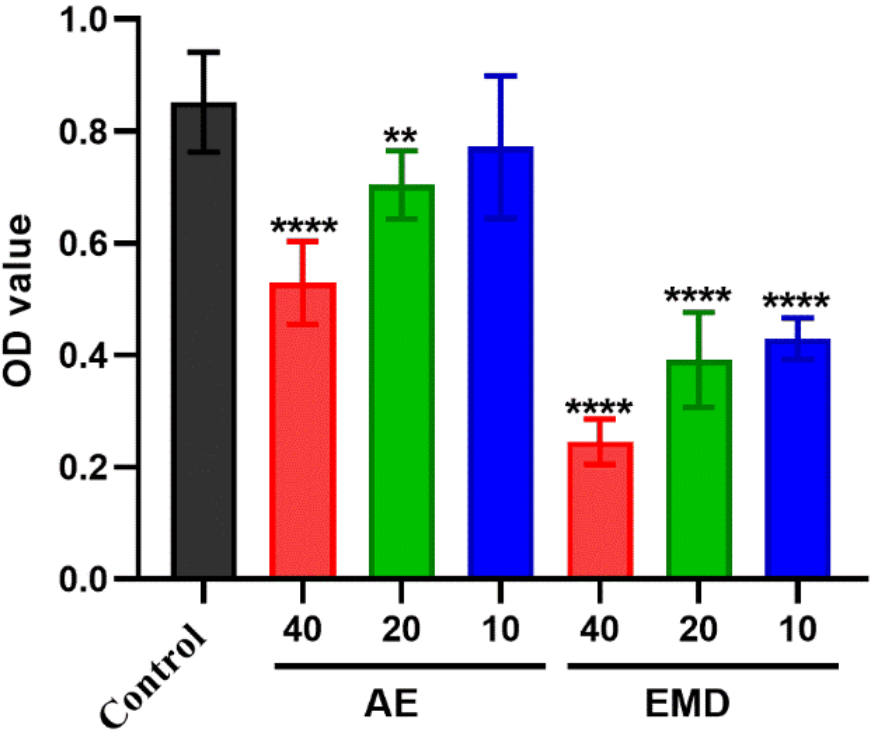
Figure 4. The effects of AE and EMD at different concentrations (40, 20, 10 μM) on the adhesion. The data are expressed as the mean ± SD ( n = 3). ** p < 0.01, **** p < 0.0001 compared with control group.